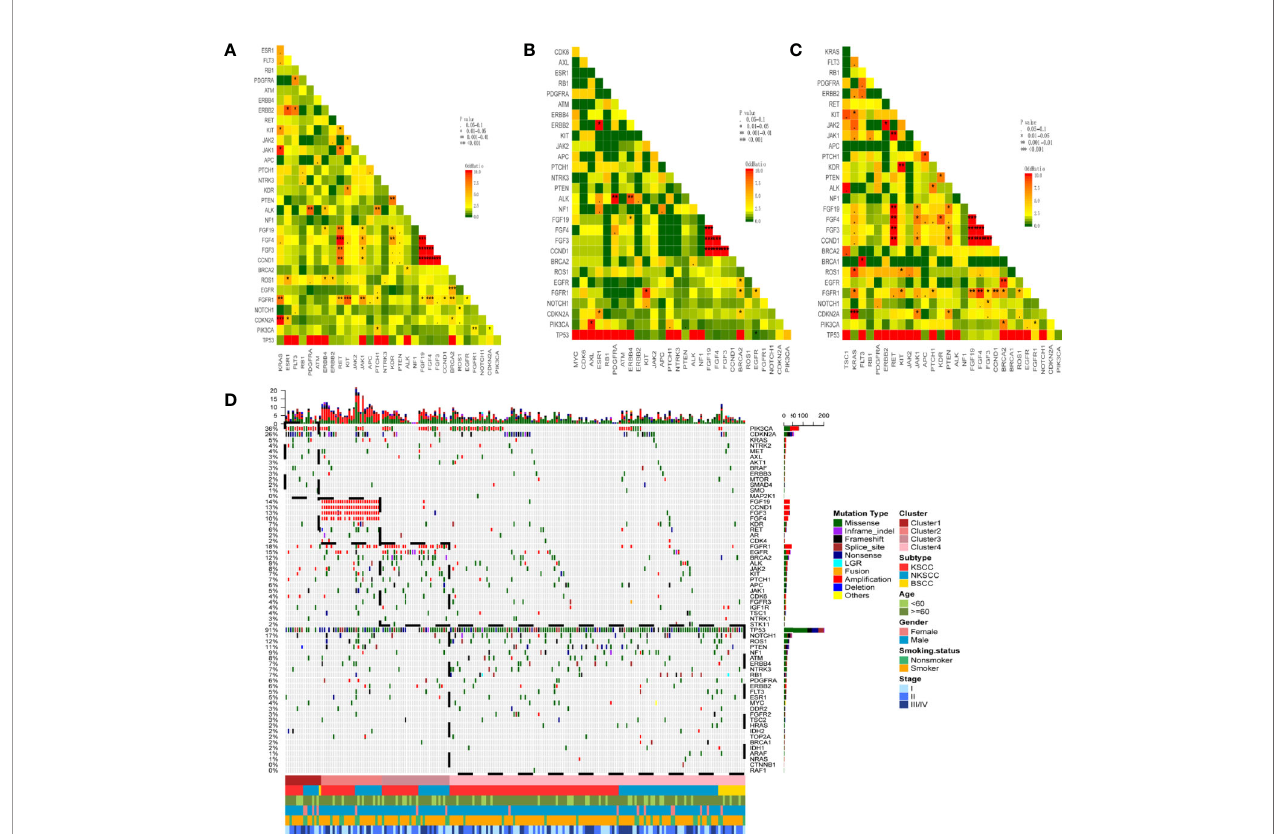
FIGURE 4 | Pairwise assessment of mutual exclusivity and association in driver genes of LUSC (A) , KSCC (B) , NKSCC (C) , respectively. The red color is associated with a positive correlation whereas green indicates mutual exclusivity. Asterisks indicate signi fi cant relationships. Co-occurrence and exclusivity of the genes in our cohort (n = 204 patients) were assessed using the Fisher ’ s exact test (D) . NMF clustering of all genes based on the somatic mutations and CNAs from 204 cases. Hierarchical clustering revealed the cluster 1 (n=16) composed by the majority of PIK3CA and CDKN2A mutations, the cluster 2 (n = 27) grouped samples with CCND1/FGF19/FGF3/FGF4 ampli fi cations, the cluster 3 (n = 30) consisted samples with FGFR1 ampli fi cations, EGFR, BRCA2 mutations and the cluster 4 (n = 131) was constituted by samples with BSCC subtype, TP53, NOTCH1, ROS1, PTEN, NF1 mutations. LUSC, lung squamous cell carcinoma; KSCC, keratinizing squamous cell carcinoma; NKSCC, non-keratinizing squamous cell carcinoma; BSCC, basaloid squamous cell